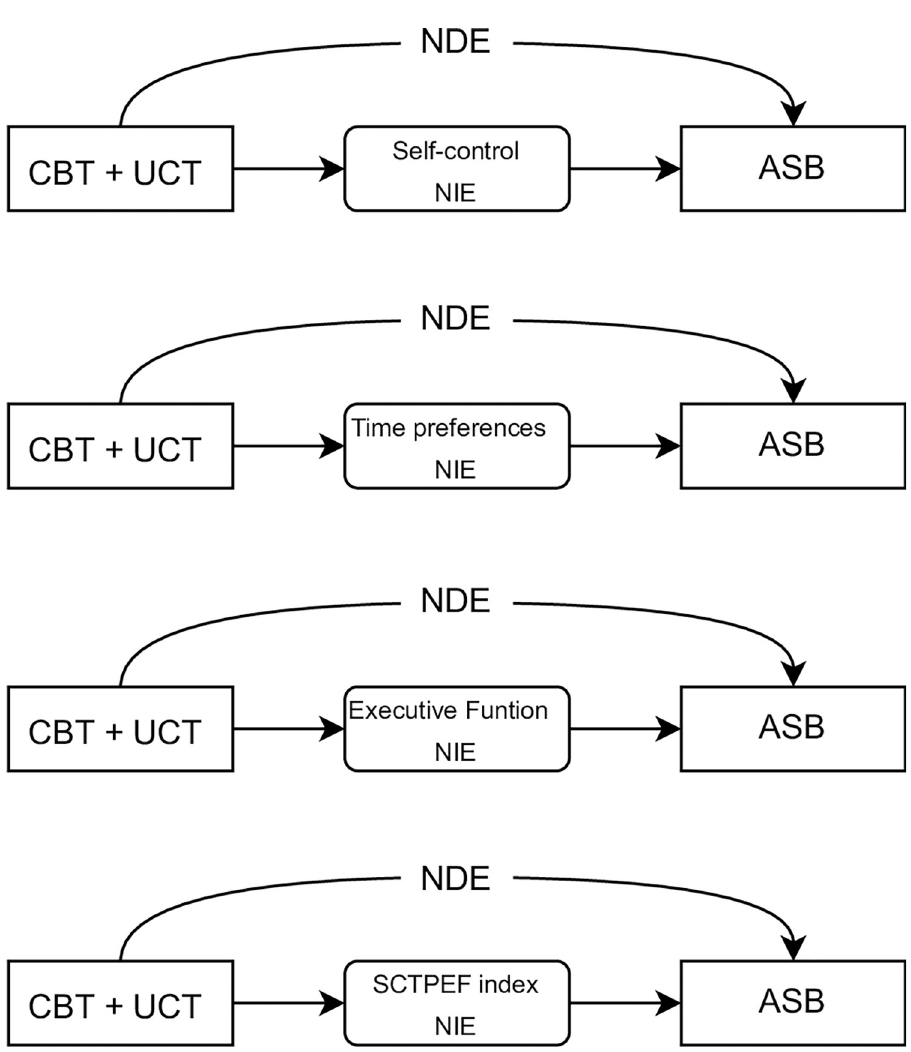
Fig 2. Direct acyclic graphs, of the STYL experiment on antisocial behavior, and hypothesized mediators. NDE, natural direct effect; NIE, natural indirect effect; SCTPEF: self-control time preferences and executive function unique index. All of these refer to the mediating effect on the association between Group CBT + UCT vs. control group over Antisocial Behavior